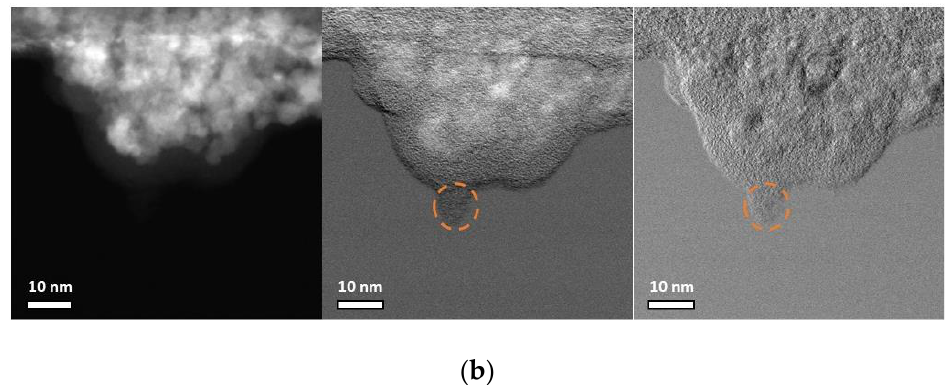
Figure 3. HAADF-STEM micrographs indicate the nanoparticle core with an amorphous coating for ( a ) ION@CMD6.25 and ( b ) ION@CMD250 on the left. The picture in the middle shows DPCx (A – C), and the right one shows DPCy (B – D). The orange markers show the artifacts created by the scanning electron beam. Scale bars are inset.